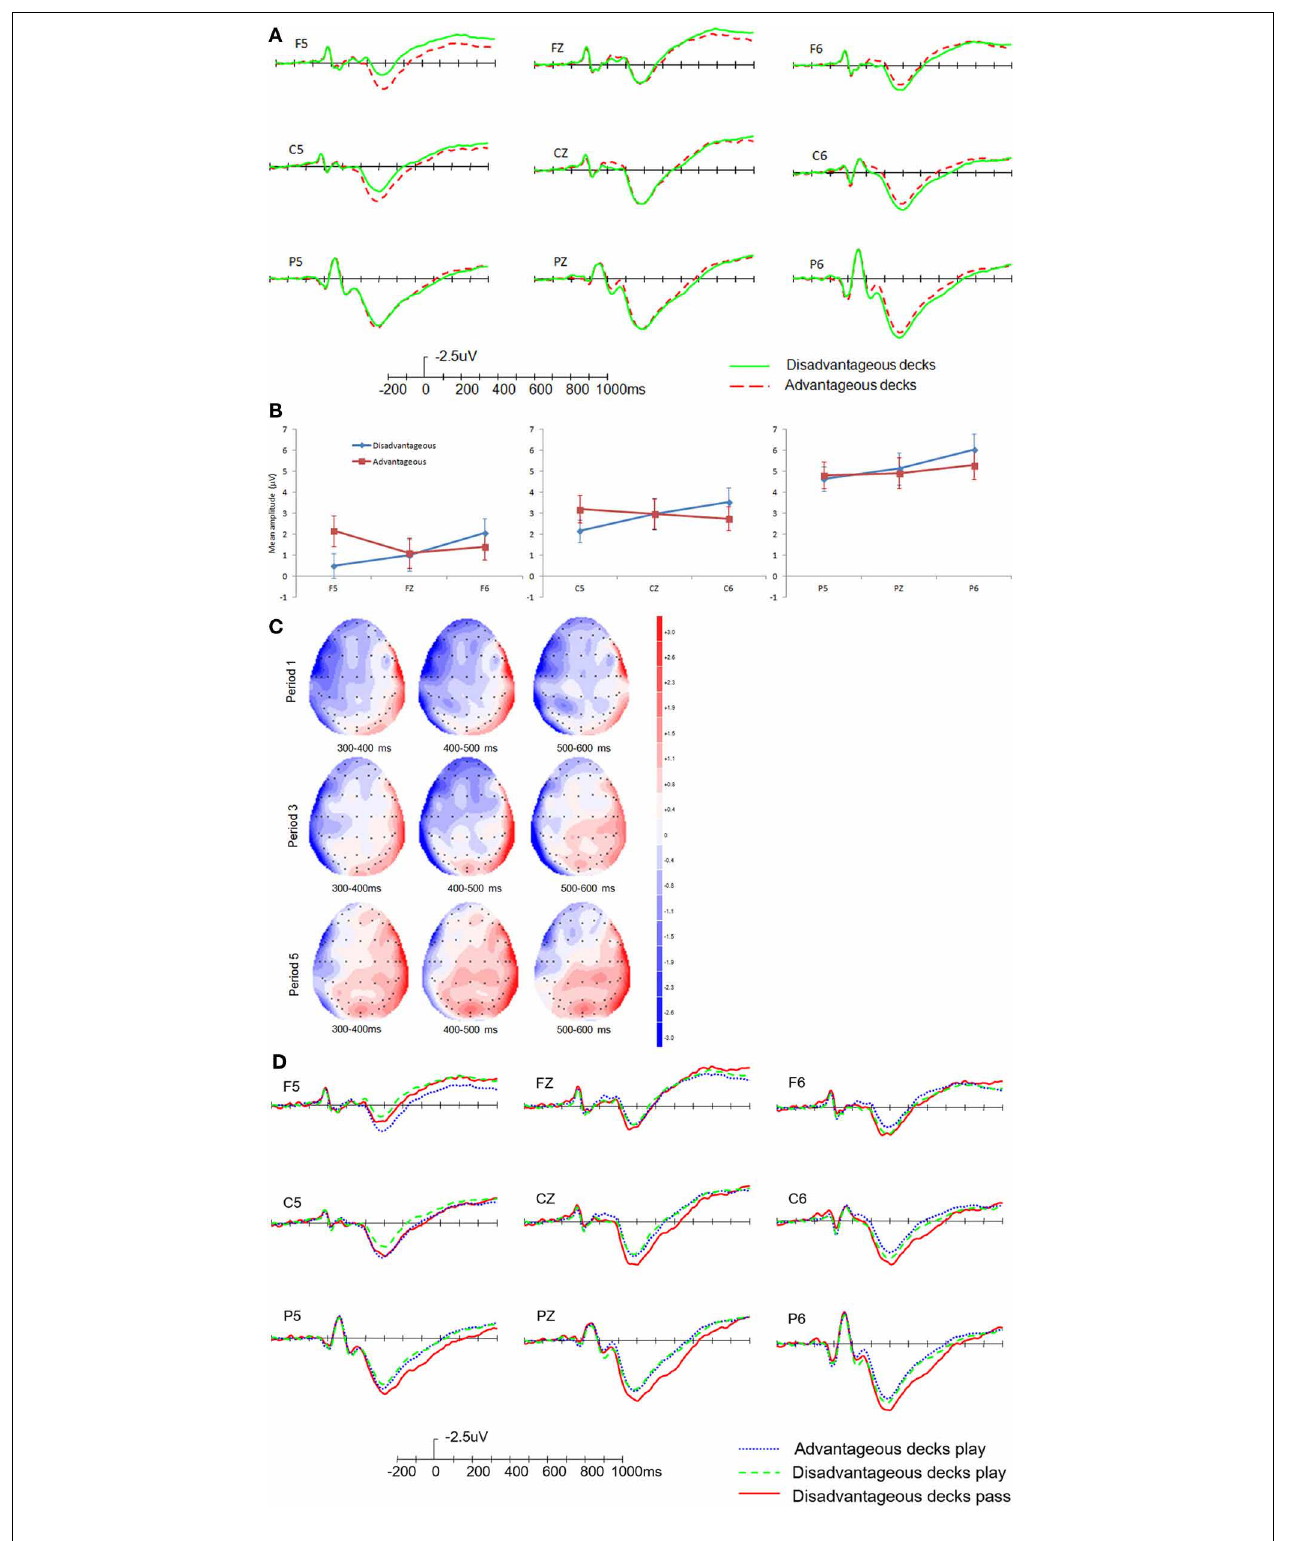
FIGURE 3 | ERP results in the choice evaluation stage. (A) Global difference between advantageous and disadvantageous decks. (B) Amplitudes of disadvantageous decks and advantageous decks in different regions. (C) Topographical maps for the